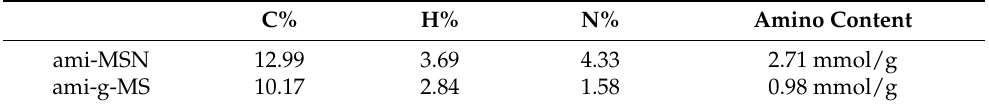
Table 1. Elemental analysis of ami-g-MS and ami-MSN.